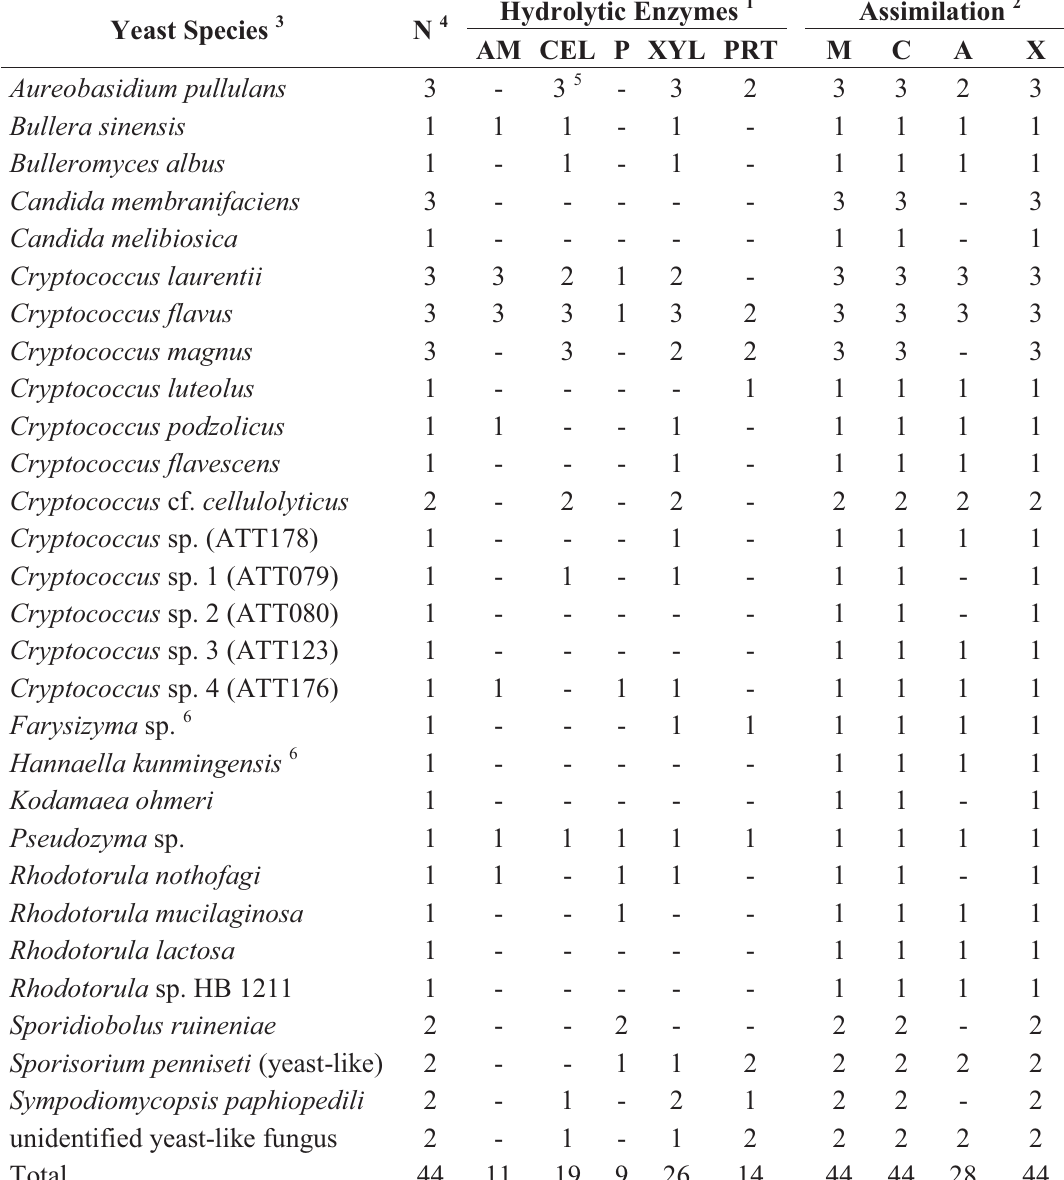
Table 1. Enzymatic activity and assimilation profile of yeasts and yeast-like fungi isolated from fungus gardens of Atta texana. Yeast Species 3 N 4 Aureobasidium pullulans Bullera sinensis Bulleromyces albus Candida membranifaciens Candida melibiosica Cryptococcus laurentii Cryptococcus flavus Cryptococcus magnus Cryptococcus luteolus Cryptococcus podzolicus Cryptococcus flavescens Cryptococcus cf. cellulolyticus Cryptococcus sp. (ATT178) Cryptococcus sp. 1 (ATT079) Cryptococcus sp. 2 (ATT080) Cryptococcus sp. 3 (ATT123) Cryptococcus sp. 4